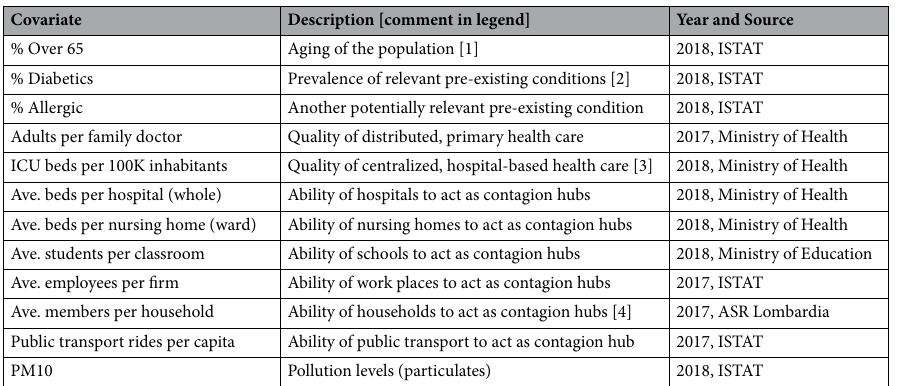
Table 1. Scalar covariates potentially affecting COVID-19 mortality. [1] The percentages of over 65, 70, 75 and 80 are highly correlated at the resolution of regions; we took over 65 as representative. [2] The prevalence of diabetes, hypertension and chronic bronchitis are highly correlated at the resolution of regions; we took diabetes as representative (allergies are not as highly collinear and were retained as a separate covariate). [3] Availability of ICU beds is also directly relevant for withstanding the impact of COVID-19 surges. [4] Average members per household is not a direct proxy of inter-generational contacts, but it may capture some of its